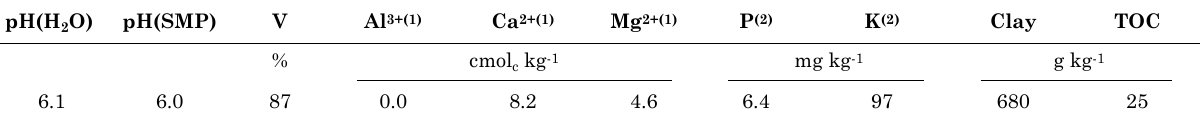
Table 1. Properties of the 0-20 cm layer of the latossolo Vermelho distroférrico (Typic Hapludox) used to set up the field experiment. Mean values of four samples composed of 10 subsamples pH(H 2 O)